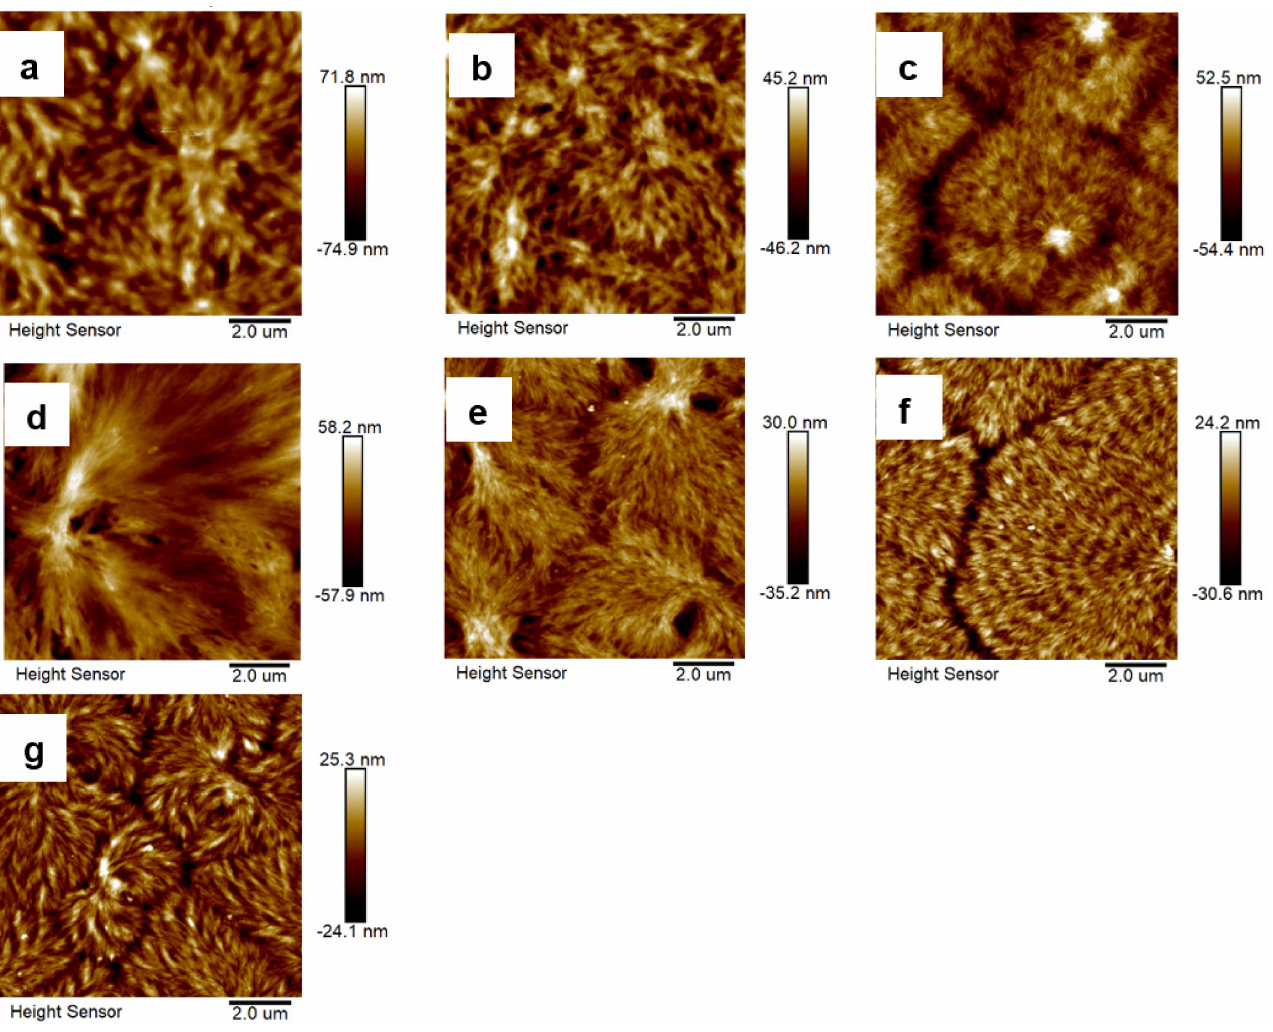
Figure 7. AFM height images of drop-casting TPAEs: ( a ) TPAE-0.76, ( b ) TPAE-0.62, ( c ) TPAE-0.43, ( d ) TPAE-0.39, ( e ) TPAE-0.25, ( f ) TPAE-0.10, and ( g ) homo